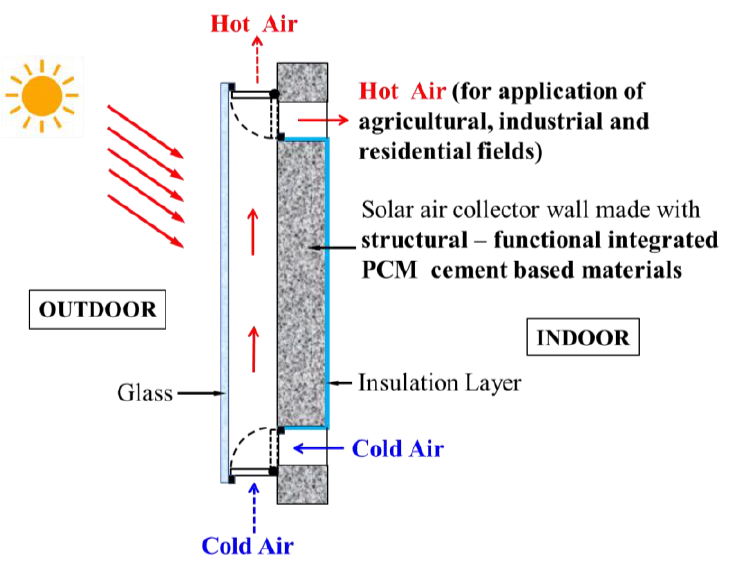
Figure 1. Schematic drawing of the solar air collector wall.